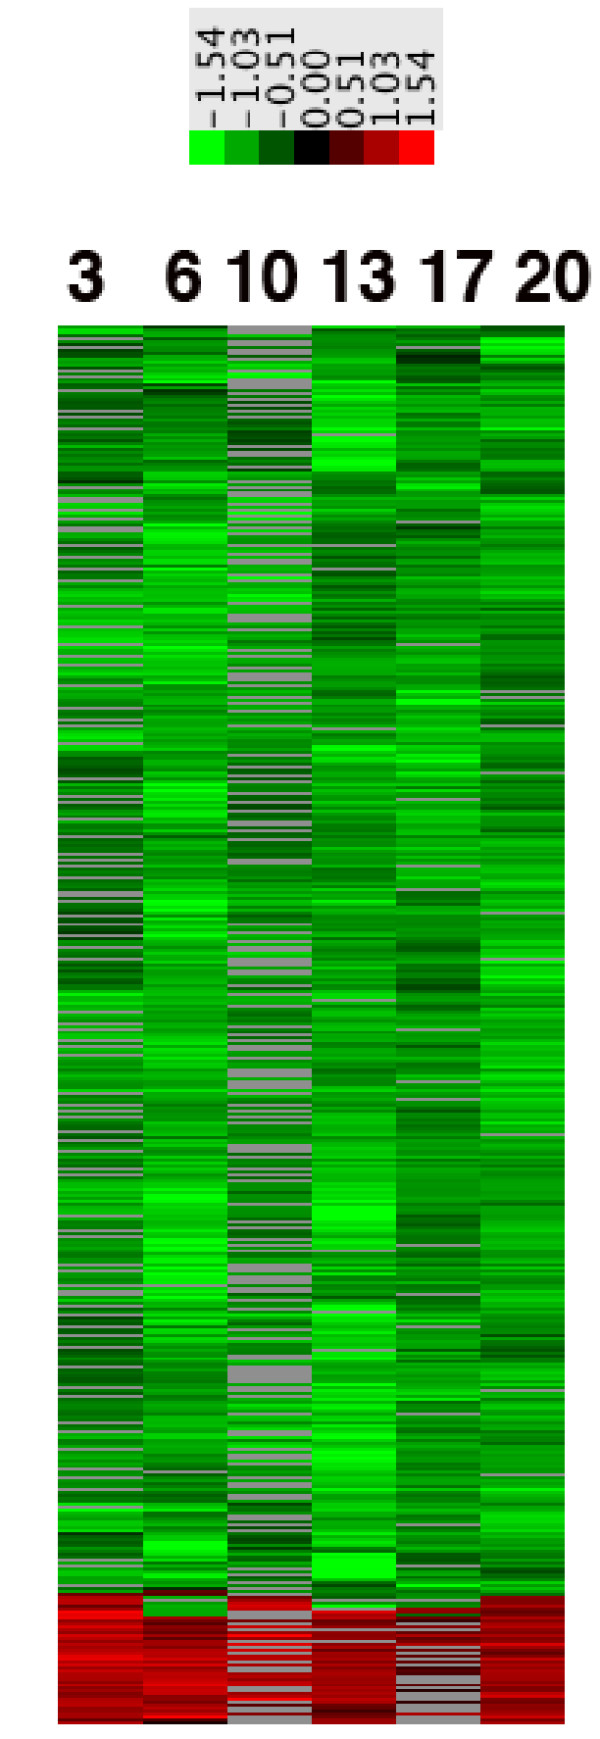
CLUSTER heatmap showing distributions of expression ratios for named genes from differentiated, rotenone-treated SH-SY5Y neural cells. Total RNA samples from the three independent rotenone incubation experiments were hybridized in duplicate on 19.2K glass microarrays. Following analysis for significance with B.A.G.E.L. software, the transcripts with P < 0.05 significance were annotated with DAVID to named genes and processed with CLUSTER to generate the heatmap. Shown are the distributions of the 1200 genes that were present in at least 50% of the samples across the time (days) of rotenone exposure. Gray spaces indicate that a particular transcript was not present. The colorbar above the heatmap shows the natural logarithm of the averaged rotenone/CTL values.